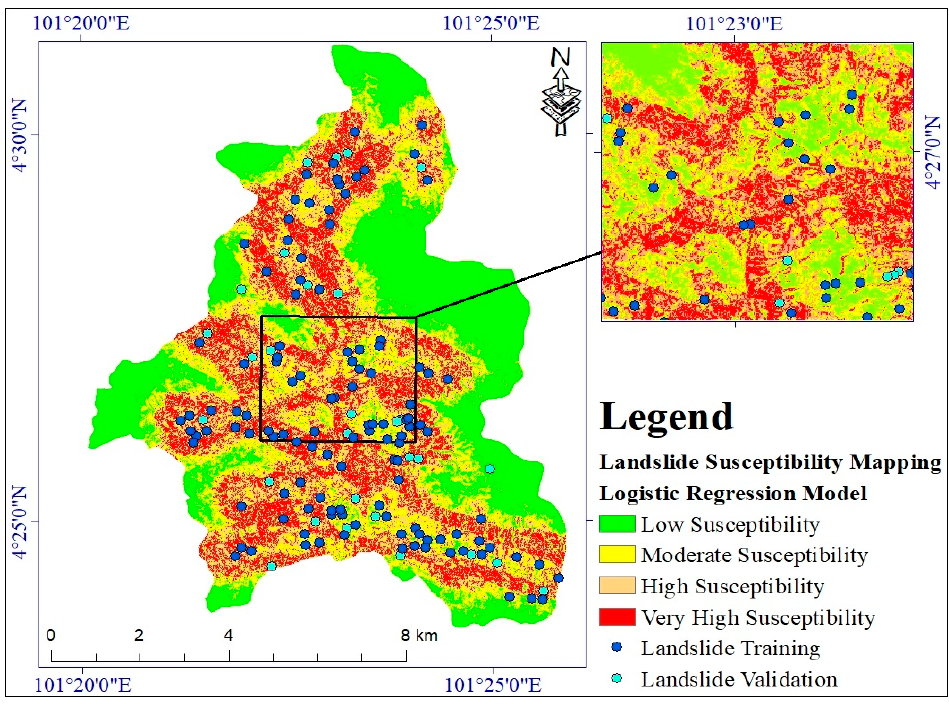
Figure 9. Landslide susceptibility map generated by the LR model.